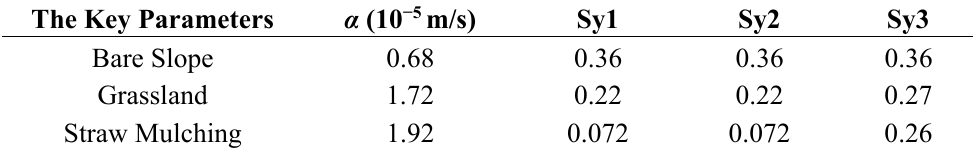
Table 1. The calibrated key parameters of the MODFLOW